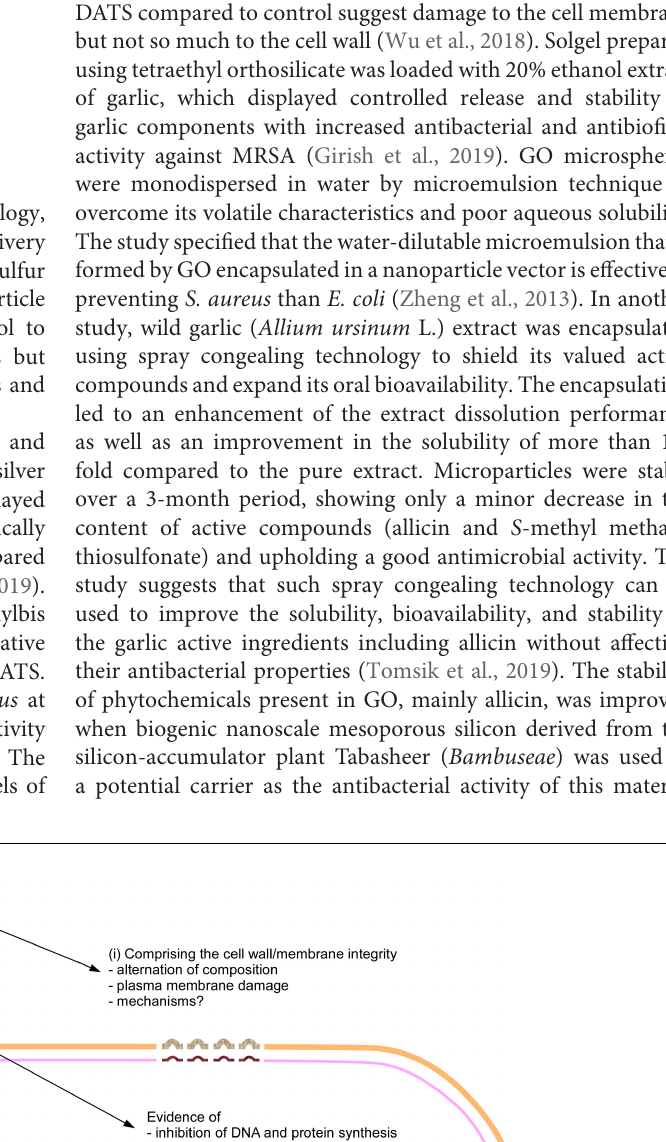
Frontiers in Microbiology |